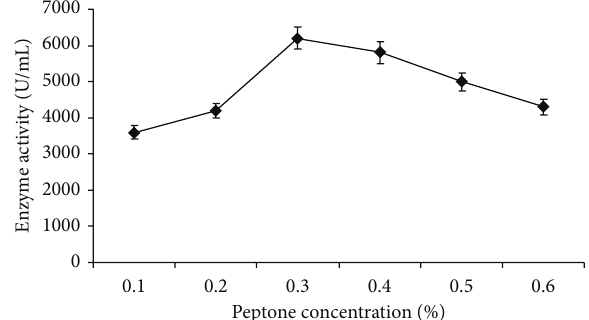
Figure 9: Effect of different concentration of peptone on amylase production. Test flasks contained different concentration of peptone (0.1–0.6%, w/v) in the medium. The flasks were inoculated with culture and incubated at 55 ∘ C for 24 h at pH 7.0. Error bars presented are mean values of ± standard deviation of triplicates of three independent